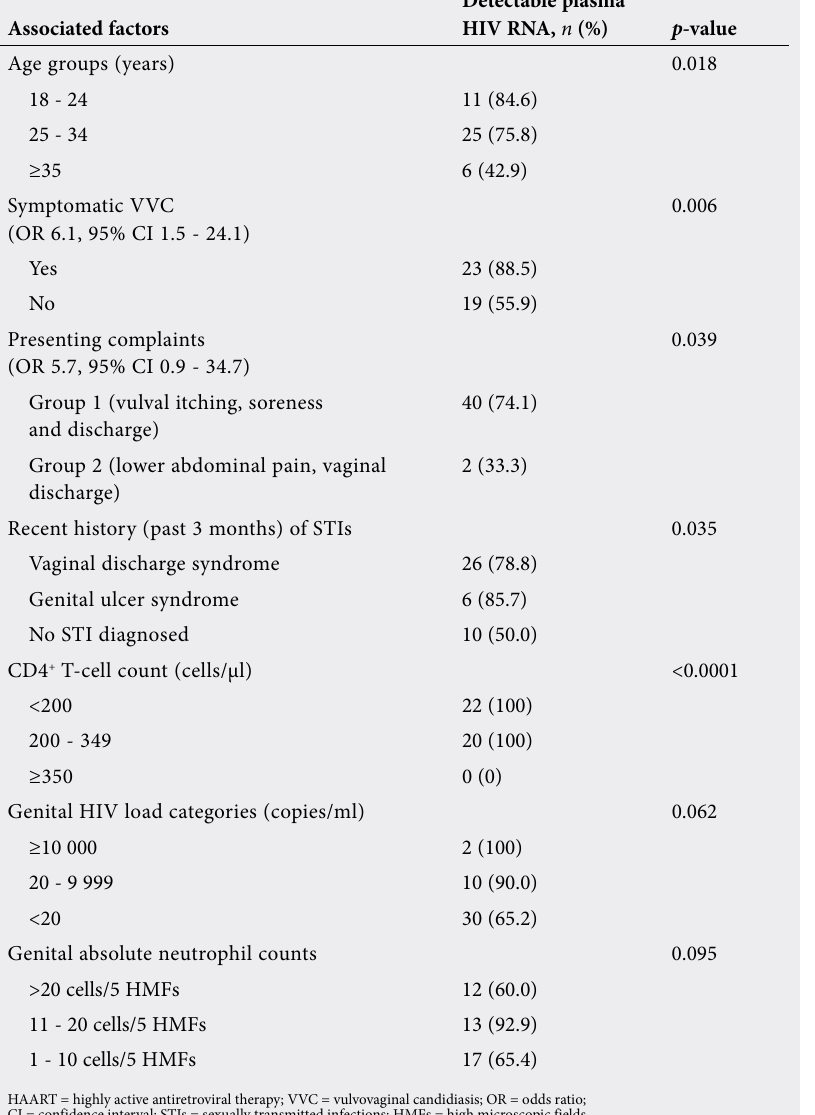
Table 2. Univariate analysis of factors associated with plasma HIV RNA levels in HIV-positive women receiving HAART ( N =60)